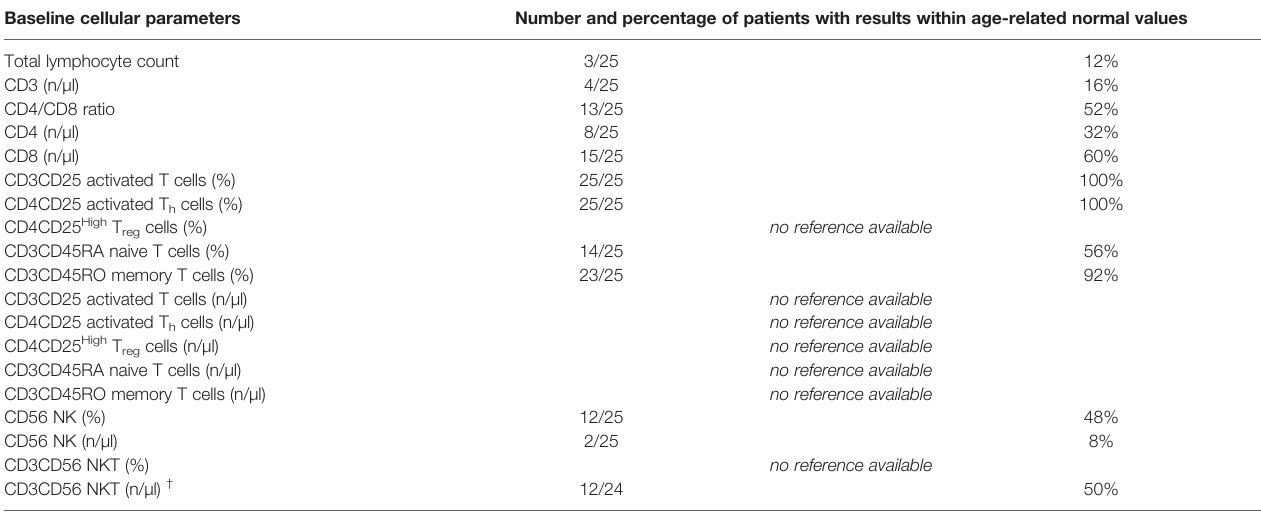
TABLE 4 | Flow cytometry results describing the baseline cellular parameters (absolute counts and percentages) compared to age-related normal values. Baseline cellular parameters Number and percentage of patients with results within age-related normal values